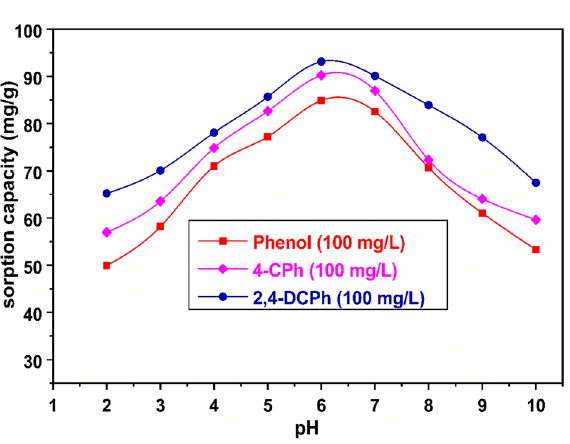
Figure 8. Effect of pH on the adsorption of phenol and CPhs (phenol (filled square), 4 - CPh (filled diamond), and 2,4-DCPh (filled circle)).